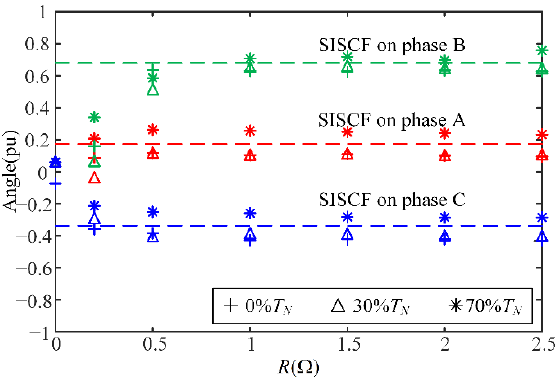
Figure 9. Park vector trajectory ellipse long axis tilt angle of simulation data.